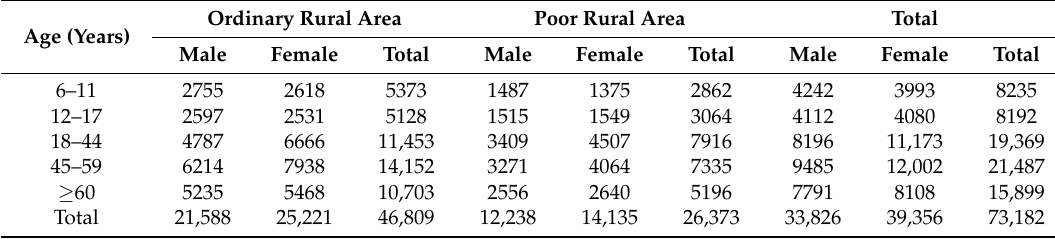
Table 3. Study population distribution by age, sex, and type of rural area ( n